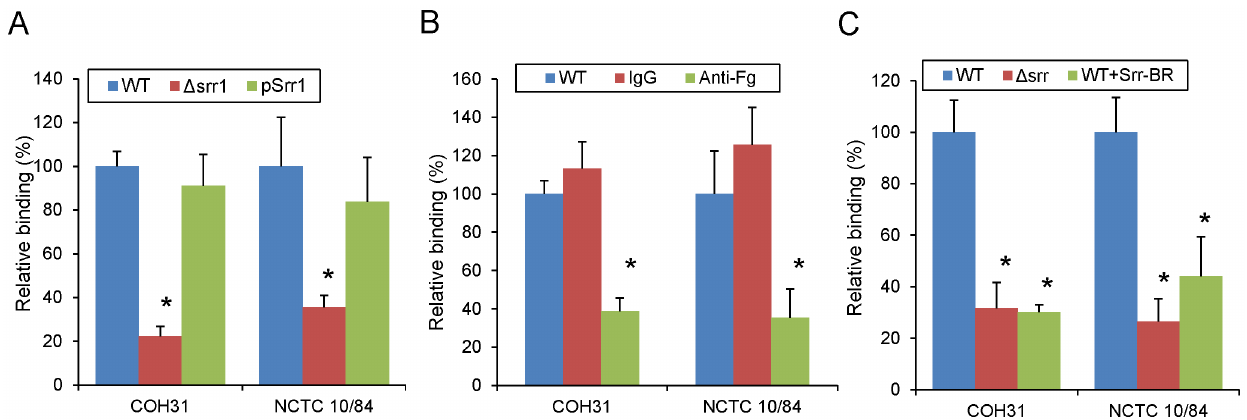
Figure 1. GBS binding to immobilized human platelets is mediated by glycoprotein Srr1. (A) Platelet binding by GBS strains COH31 and NCTC 10/84, their D srr1 isogenic variants, and the mutant strains complemented in trans with srr1 (pSrr1). (B) GBS binding to human platelets was inhibited by pretreating the monolayers with 100 m g/ml of anti-fibrinogen IgG (Anti-Fg). Normal IgG (IgG) served as a control. (C) Inhibition of binding by recombinant Srr1 binding region (Srr1-BR). Levels of binding were calculated as relative to the WT strains (mean 6 SD). Values shown represent the means ( 6 S.D.) of triplicate measurements. *=P , 0.01.